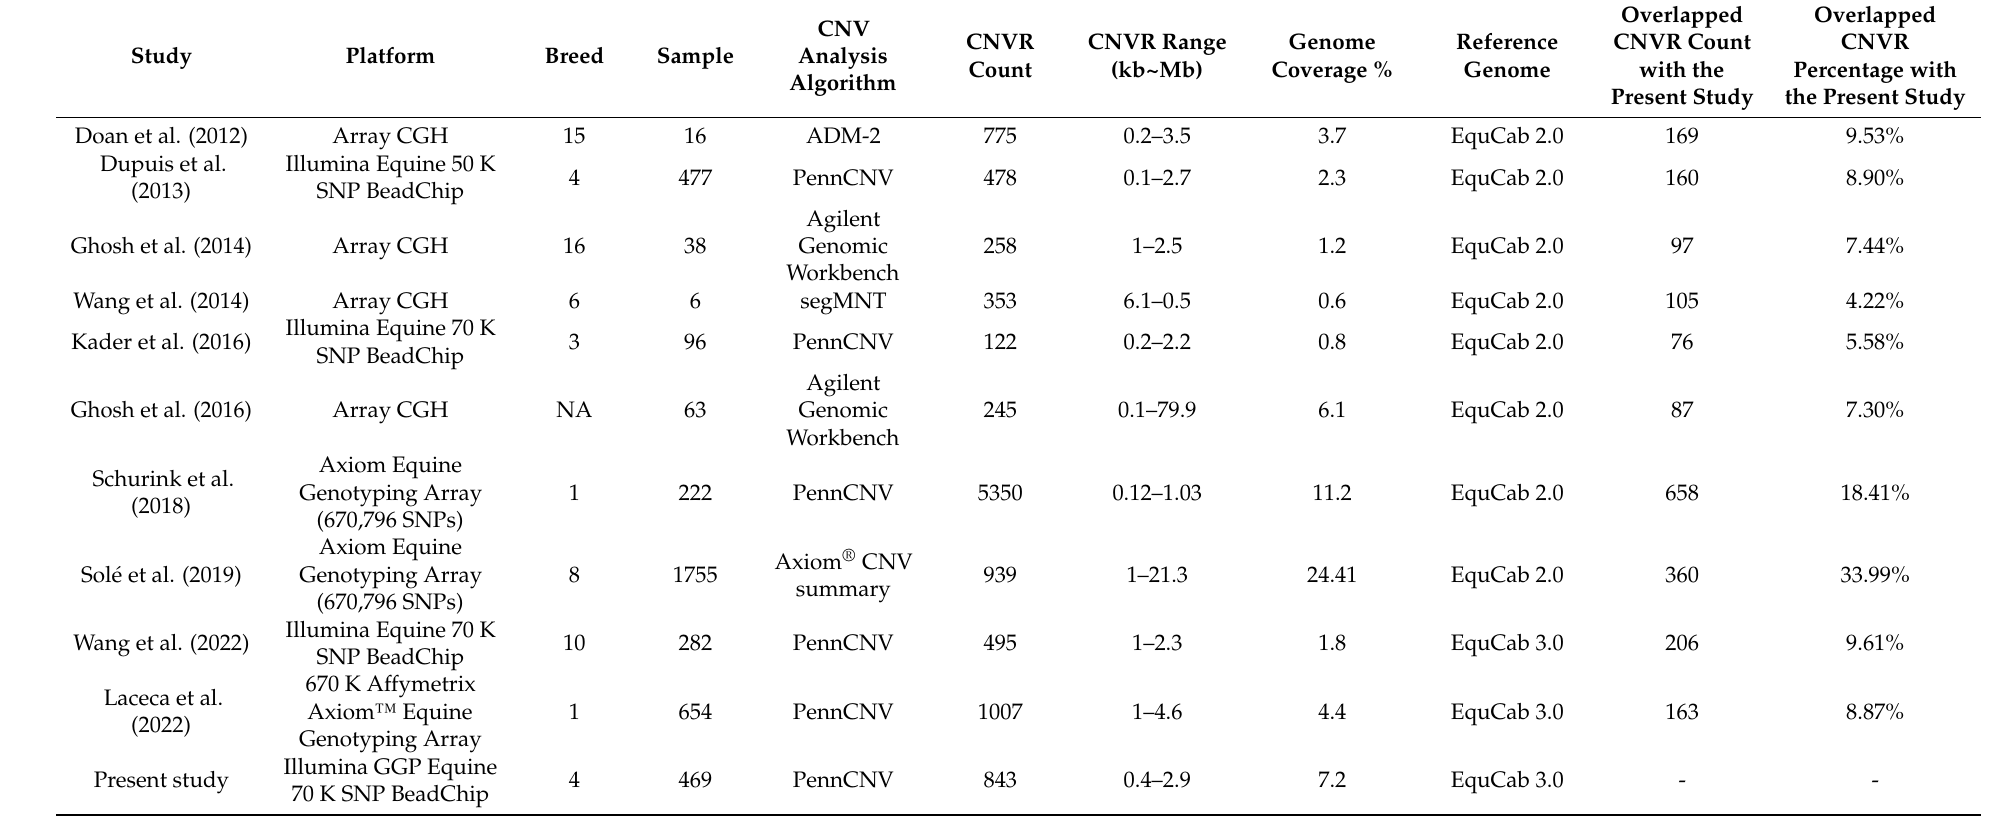
Table 3. Comparison of reported copy number variation regions (CNVRs) for horses ( Equus caballus